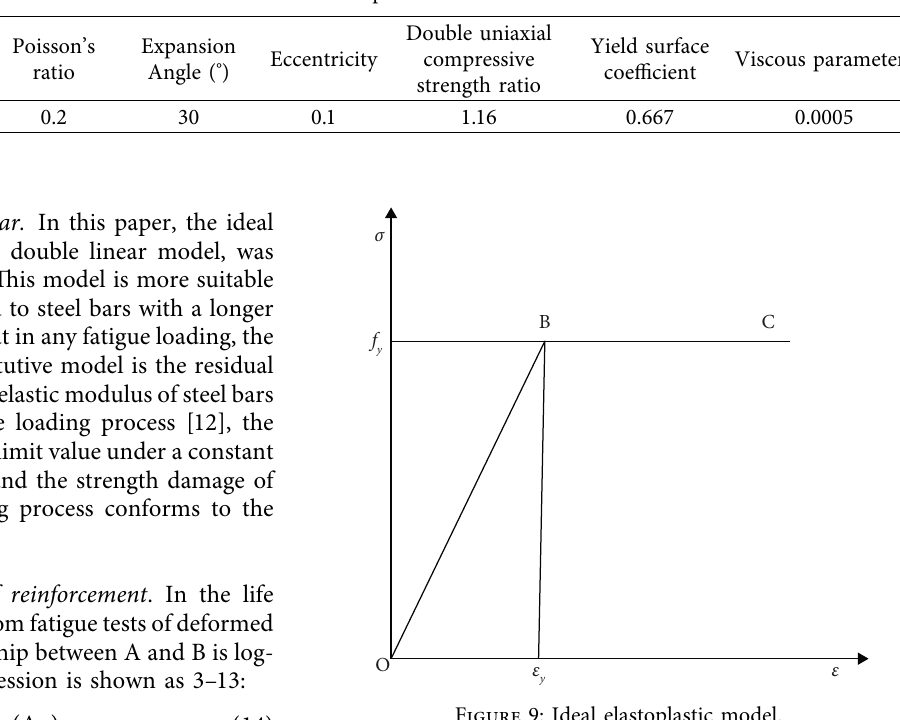
Table 3: Concrete material parameters.